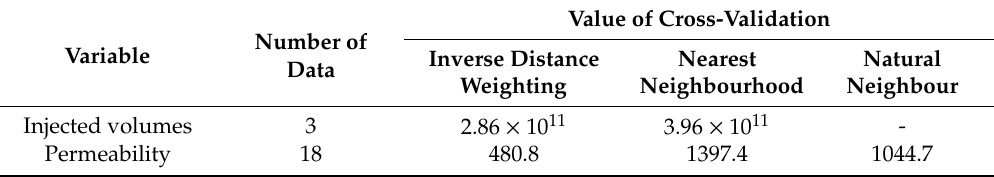
Figure 9. Results of IDW, NN and NaN methods (from top to bottom) of the permeability ( left ) and injected volumes ( right ) in the “K” reservoir. Faults are marked with letters, as mentioned in the text. Table 3. Cross-validation values for 3 methods and 2 variables in the “K”